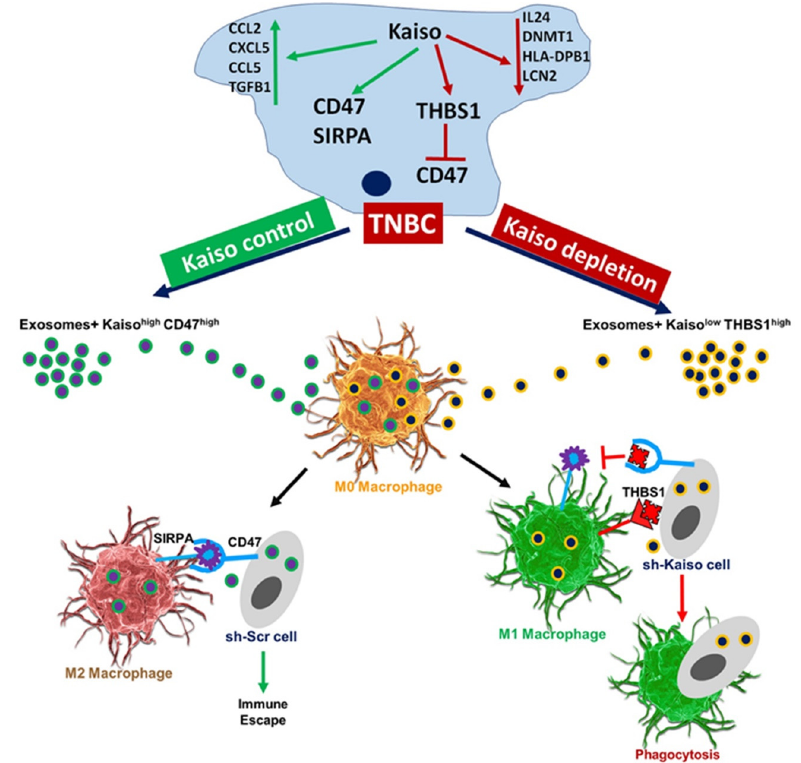
Figure 7. Summary. Figure 7.